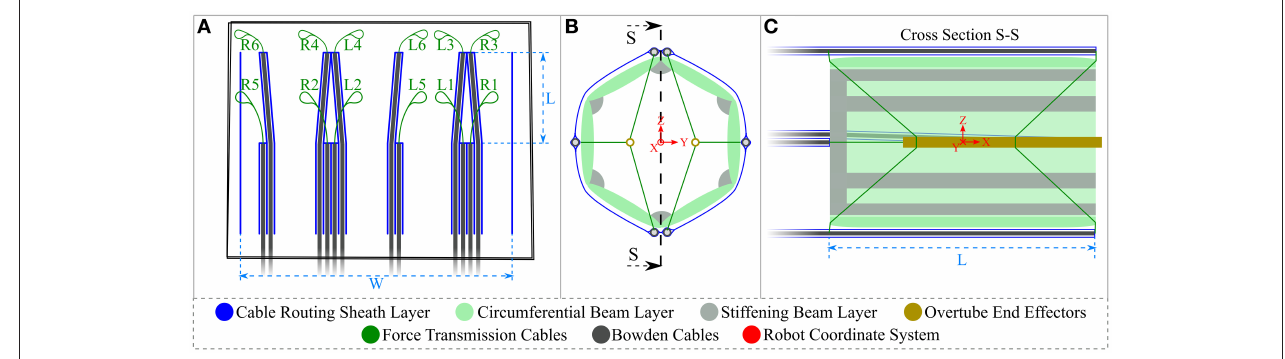
FIGURE 5 | Cable sheath and CYCLOPS schematic diagram (A) cable sheath design in blue showing Bowden cables and force-transmission cables, where the vertical line welds on the right and left are later manually welded to produce a cylinder (B) front view of CYCLOPS where the inflatable structure and sheath are in place, the cables are attached to the brass overtubes and also showing the origin of the coordinate system in red (C) cross sectional view showing entry points of cables to the structure interior, the attachment points on the overtubes and the robot’s coordinate system in red. Not to scale.